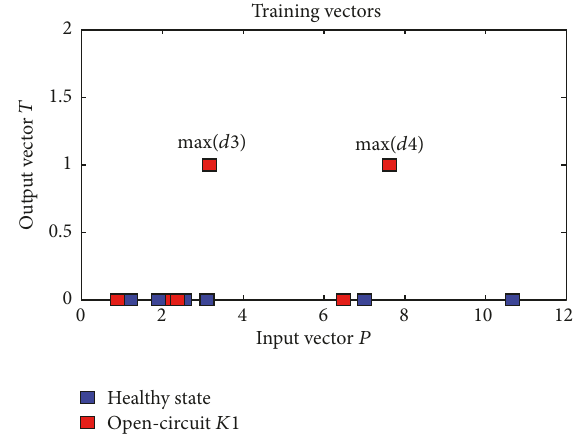
Figure 11: Variation of the details